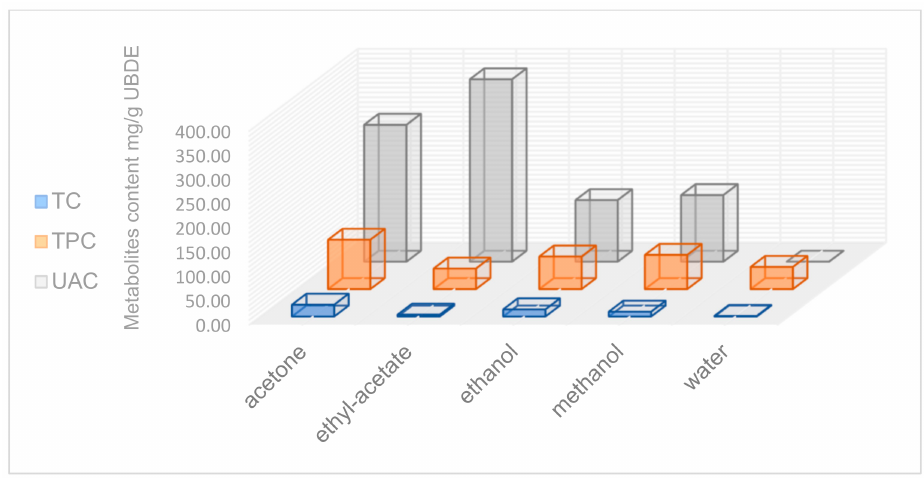
Figure 2. The secondary metabolite content (UAC, TPC, and TC) in UBDE in different solvents.